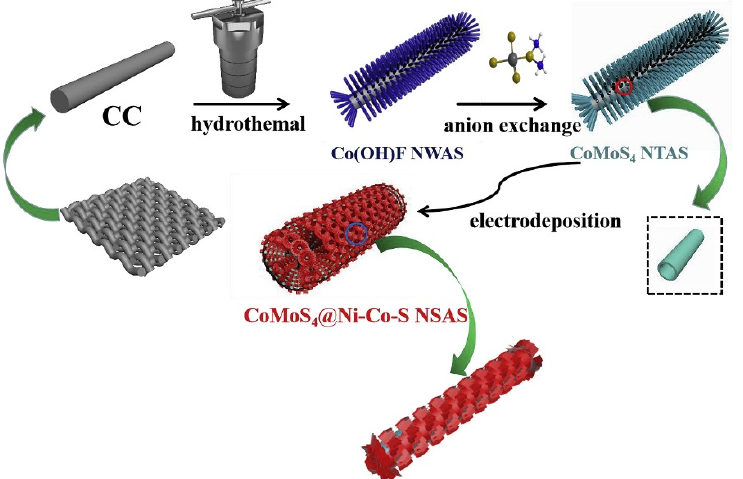
Figure 13. Schematic illustration of the fabrication of a hierarchical core-shell hollow CoMoS 4 @Ni- Co-S nanotubes electrode. Reproduced with permission from Fei Ma, Hierarchical core-shell hollow CoMoS 4 @Ni-Co-S nanotubes hybrid arrays as advanced electrode material for supercapacitors; pub- lished by Elsevier, 2019 [163] .